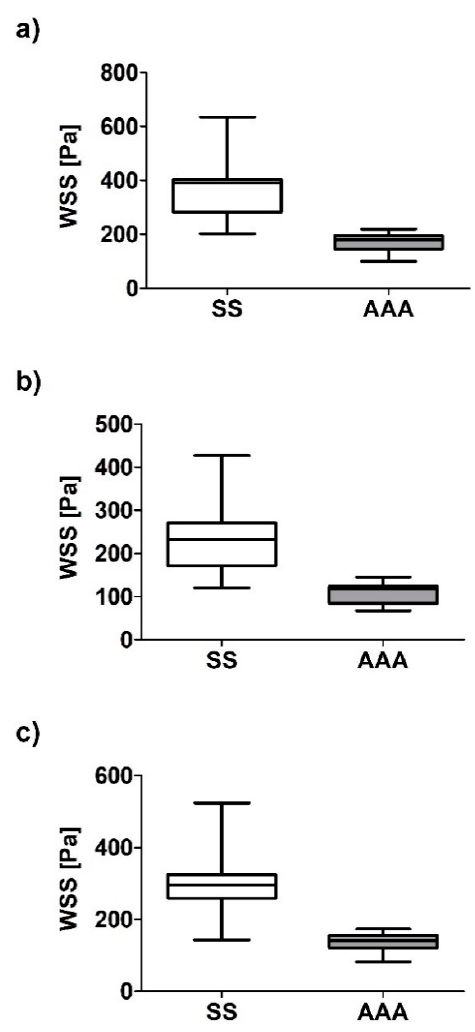
Figure 9. Bar chart representation of WSS value between aneurysm and stent-graft for abdominal aortic aneurysm (AAA) and short stent-graft (SS) for: ( a ) Sharp velocity profile, ( b ) flat velocity profile, ( c ) real velocity profile.